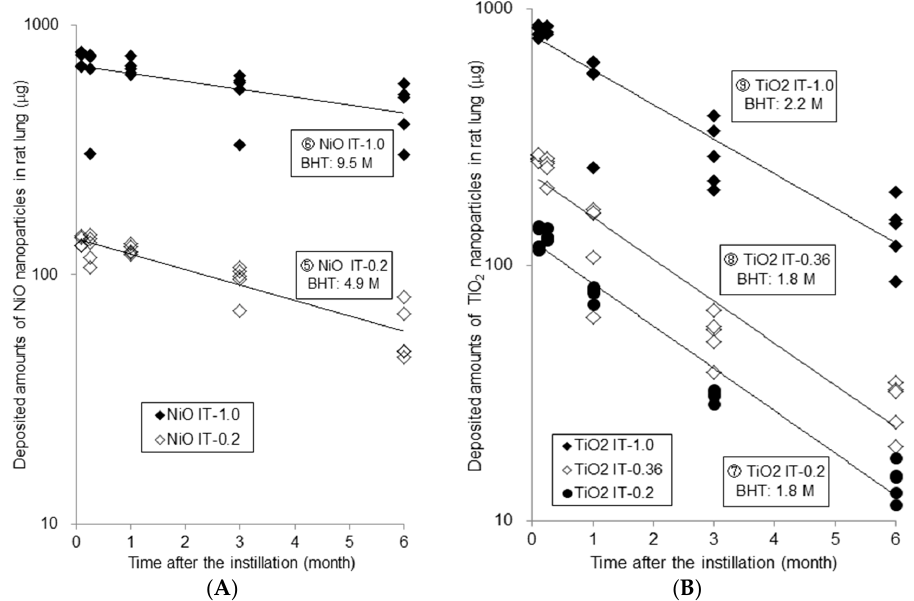
Figure 2. Biopersistence of NiO and TiO 2 nanoparticles in rat lungs in intratracheal instillation studies. ( A ) NiO nanoparticles; ( B ) TiO 2 nanoparticles.